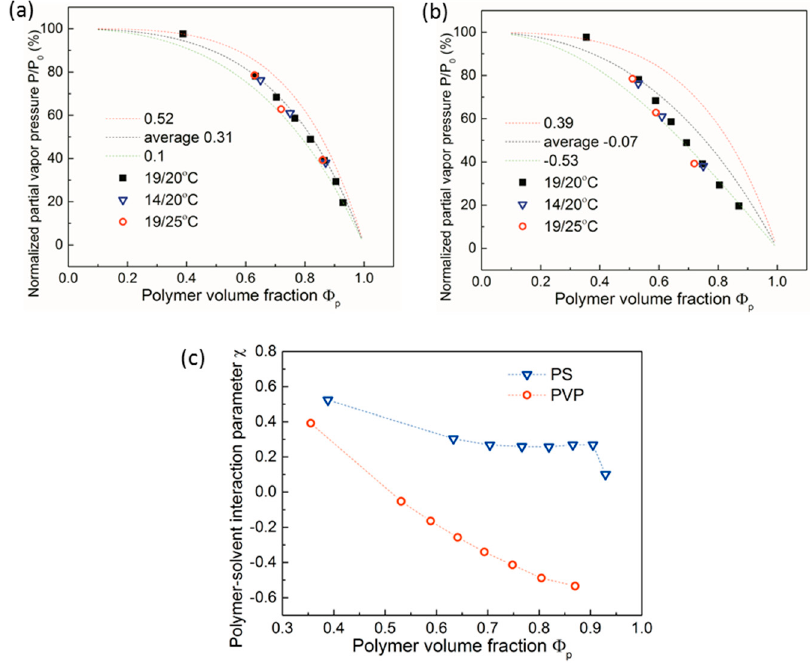
Figure 8. Polymer volume fraction Φ p in swollen ( a ) PS and ( b ) P2VP films with an initial thickness of ~40 nm versus normalized partial vapor pressure P / P 0 of chloroform at indicated temperatures. Data points were measured at T v / T s of 19 ◦ C / 20 ◦ C (black squares), 14 ◦ C / 20 ◦ C (blue hollow triangles), and 19 ◦ C / 25 ◦ C (red hollow circles), respectively. Dashed curves are calculated fits according to Equation (2) with a fixed polymer–solvent interaction parameter χ ( a ) 0.13 (green), 0.68 (red), and 0.41 (black), and ( b ) − 0.51 (green), 0.39 (red), and 0.02 (black). ( c ) Polymer–solvent interaction parameter c as a function of polymer volume fraction Φ p of PS (blue hollow triangles) and P2VP (red hollow circles) ~40 nm thick films in chloroform vapor with step wise increasing partial vapor pressure.